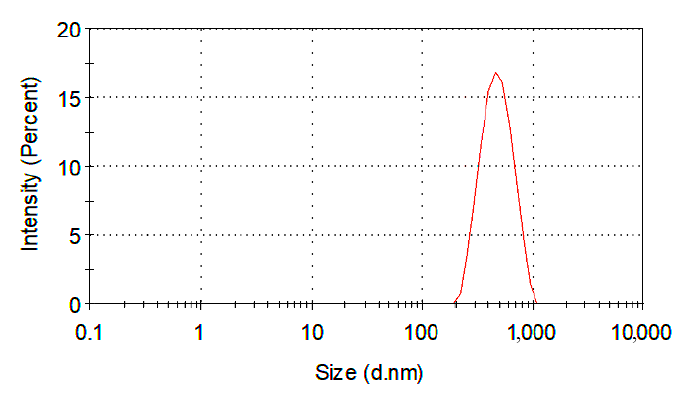
Figure 6. Particle size distribution by intensity of PMMA@P(MAA-co-EGDMA) core-shell copolymer.